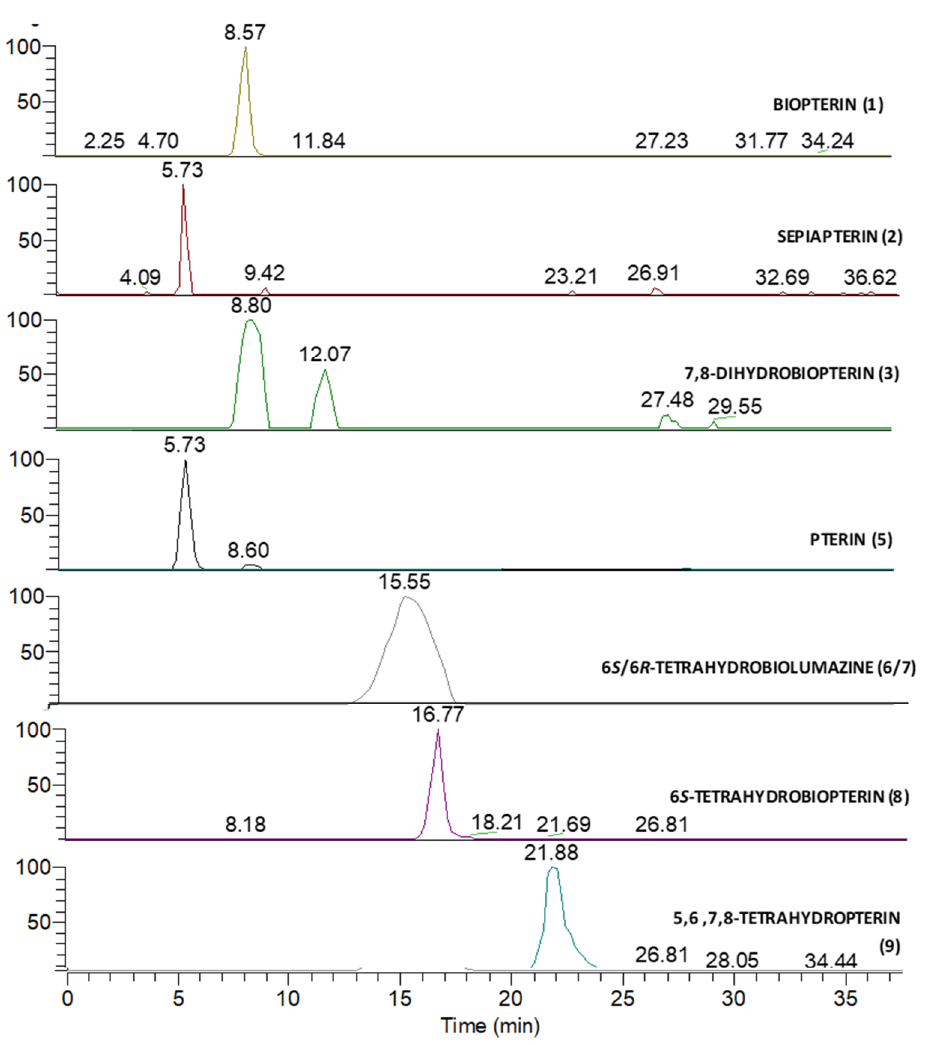
Figure 2. Extracted ion chromatogram (XIC) of compounds obtained by selecting exact masses of [M + H] + and [M + Na] + ions of each compound (see Table S1).